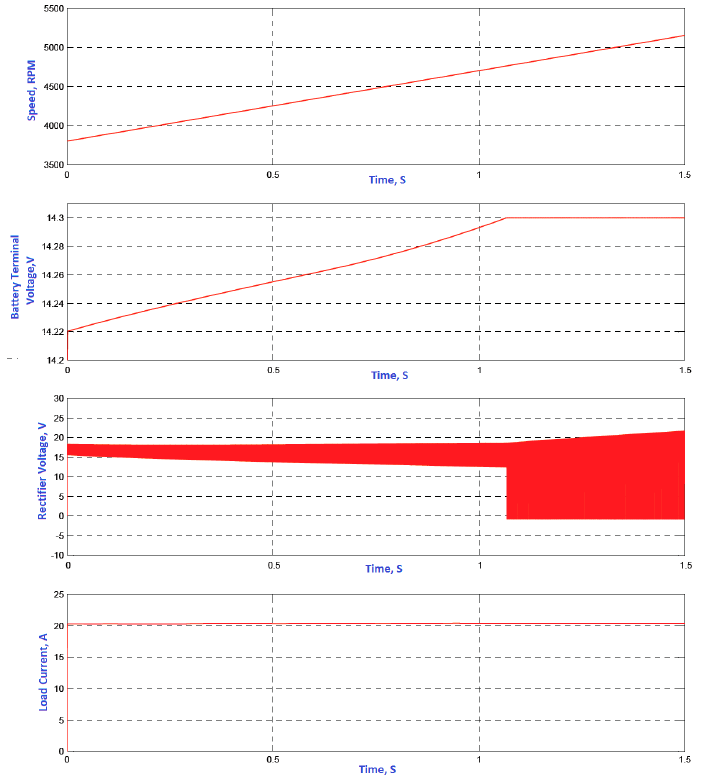
Figure 16. Simulation results for constant electrical load and variable AFPMA speed.